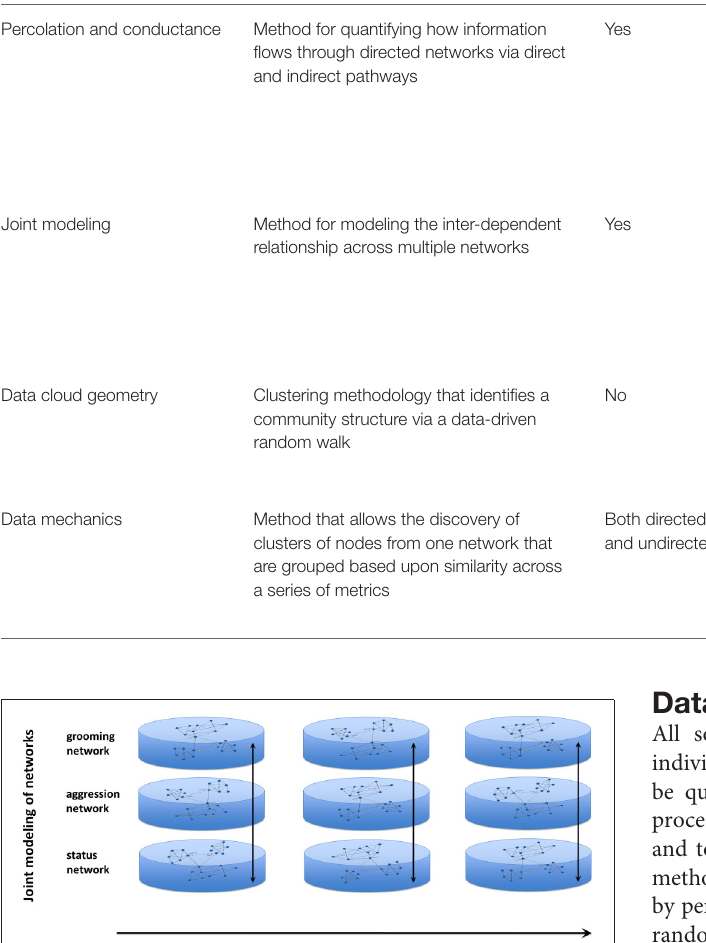
null model, the relationships across interactions are assumed to be independent, e.g., knowing that John never calls Sally is independent of whether Sally and John e-mail each